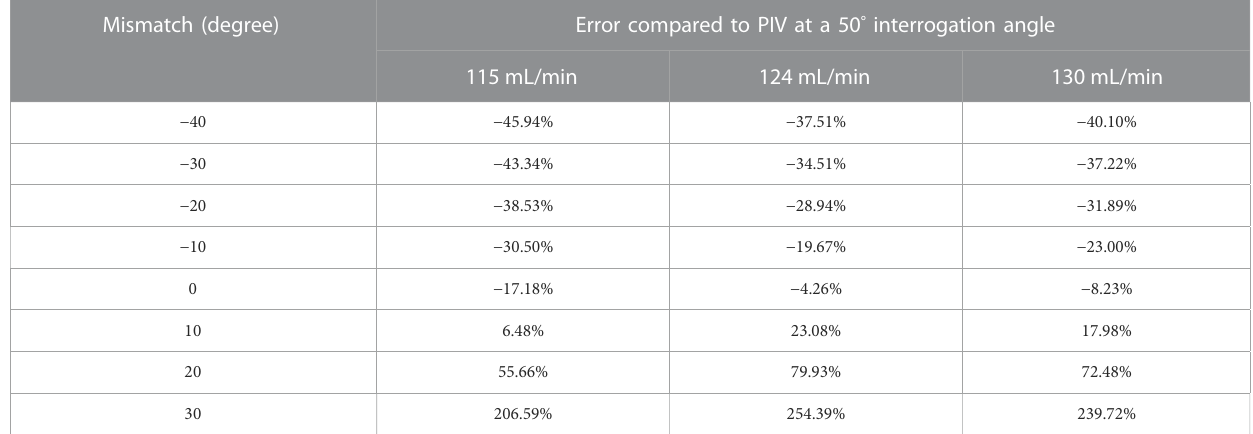
TABLE 4 Velocity measurement error at 50 ° interrogation angle for several angular mismatches. Mismatch